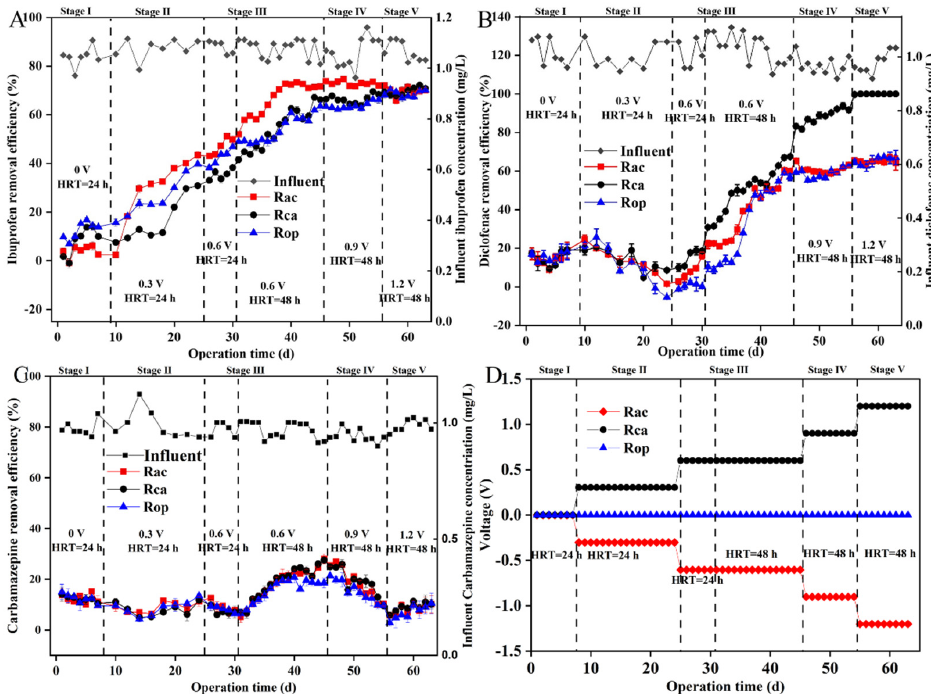
Figure 2. Ibuprofen ( A ), diclofenac ( B ), and carbamazepine ( C ) removal performances of AO − UBERs and the applied voltages of Rac, Rca, and Rop ( D ), with the influent pharmaceutical concentration in right y axis.